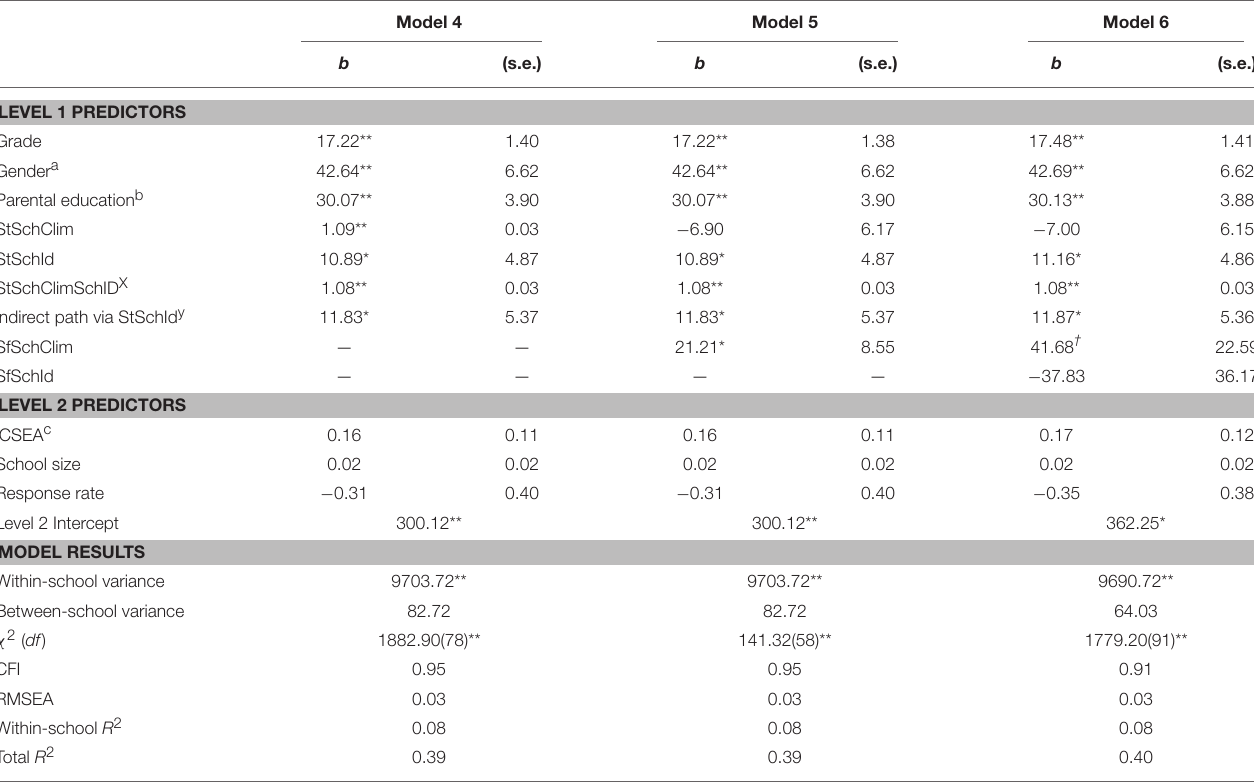
TABLE 8 | Multilevel SEM results for models 4–6 explaining NAPLAN